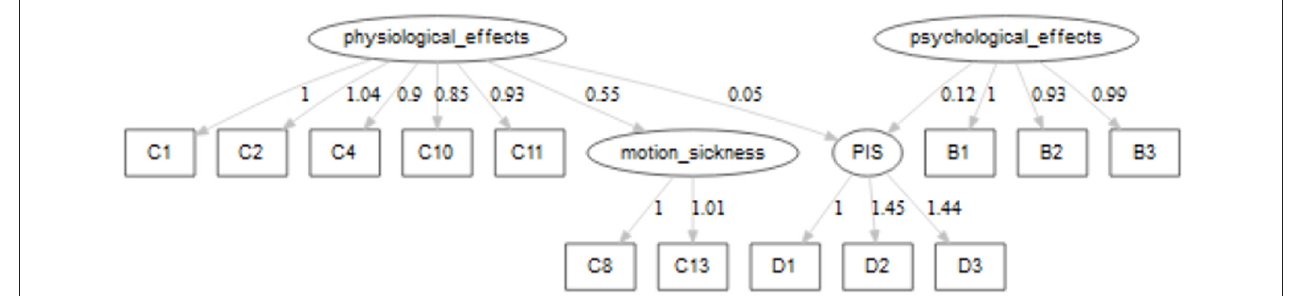
FIGURE 3 | Flowchart of the SEM for the final